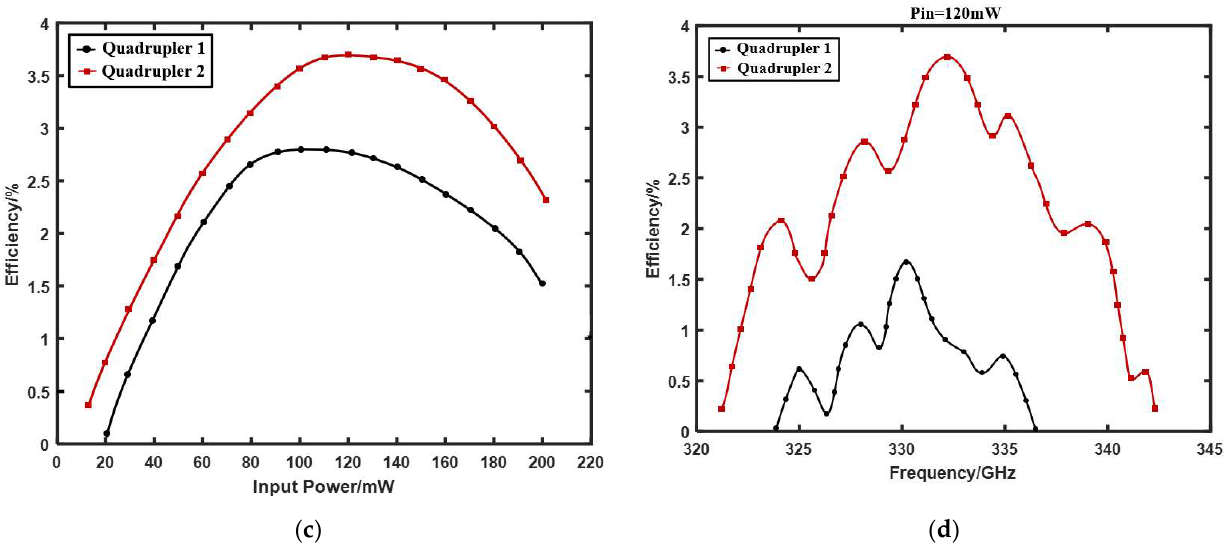
Figure 8. ( a ) Output power vs. frequency (fixed input power of 200 mW); ( b ) output power vs. bias (Quadrupler 2 and Quadrupler 2 at 333 GHz); ( c ) efficiency vs. input power (Quadrupler 2 and Quadrupler 2 at 333 GHz); ( d ) efficiency vs. frequency (fixed input power of 120 mW).